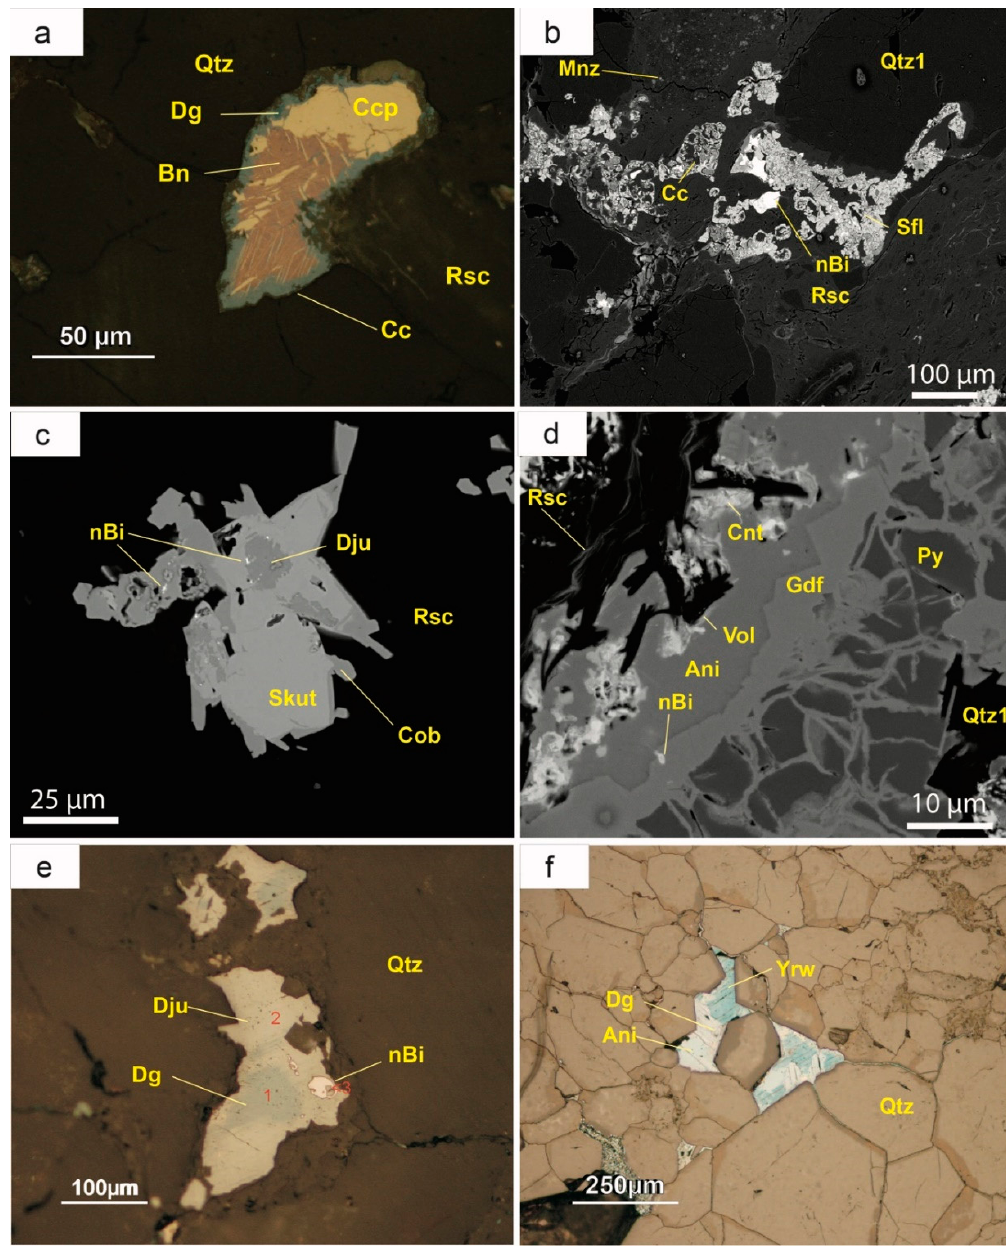
Figure 7. ( a ) Chalcopyrite grain (Ccp) interstitial to roscoelite (Rsc) and detrital quartz (Qtz), replaced by bornite (Bn), which was subsequently replaced by chalcopyrite (Cp) and finally by digenite (Dg) and chalcocite (Cc); ( b ) Chalcocite grains (Cc) interstitial to roscoelite (Rsc) with monazite (Mnz) and detrital quartz (Qtz1), mantled by safflorite (Sfl) and native bismuth (nBi); ( c ) Skutterudite grains (Skut), scattered in quartz (Qtz), mantling djurleite (Dju) and native bismuth (nBi). Skutterudite is mantled by cobaltite (Cob); ( d ) Pyrite (Py) was veined and overgrown by gersdorffite (Gdf) and native bismuth (nBi), and late anilite (Ani). Note quartz (Qtz) and roscoelite laths (Rsc) in the groundmass, partly replaced by carnotite (Cnt) and volborthite (Vol); ( e ) Digenite (Dg) replaced by djurleite (Dju) associated with native bismuth (nBi), interstitial to quartz (Qtz); ( f ) Digenite (Dg) interstitial to detrital quartz (Qtz), replaced by anilite (Ani) and finally by yarrowite (Yrw). (a,e,f) are reflected light images, PPL. (b–d) are SEM images, BSE